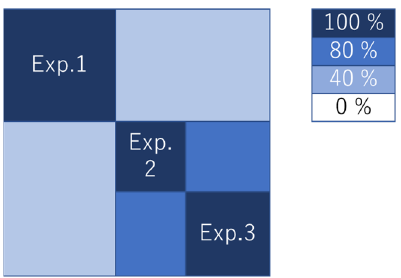
Fig. 4. Assumed correlation between experimental data